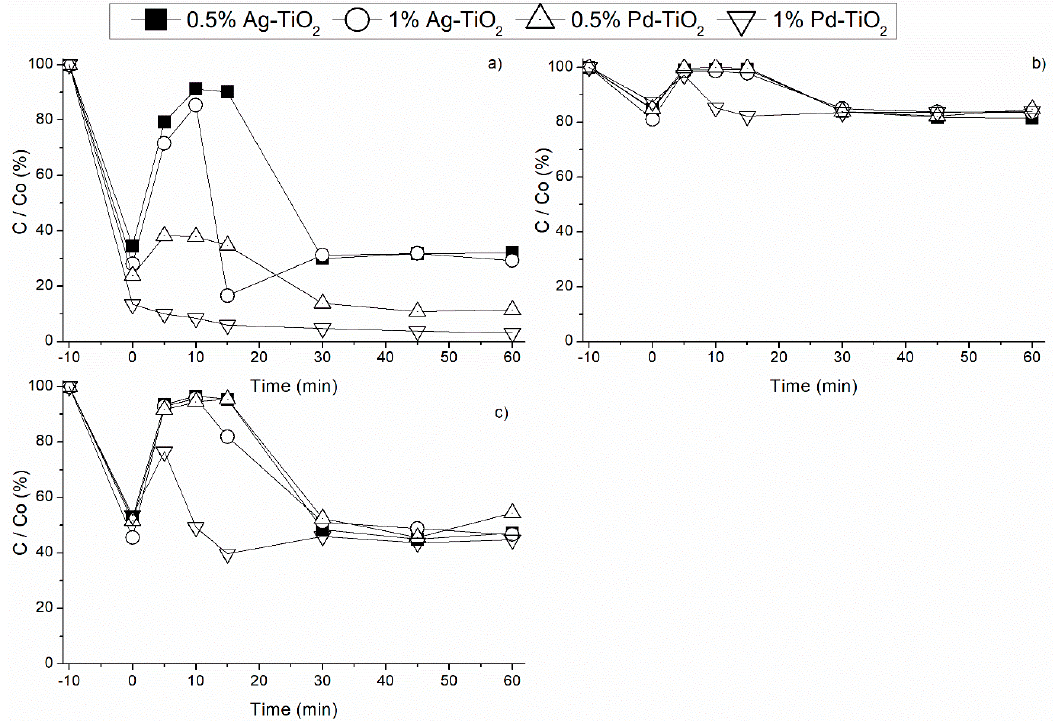
Figure 7. Contaminant (( a ) SMX, ( b ) CBZ and ( c ) LRZ) degradation during photocatalytic oxidation using visible light.